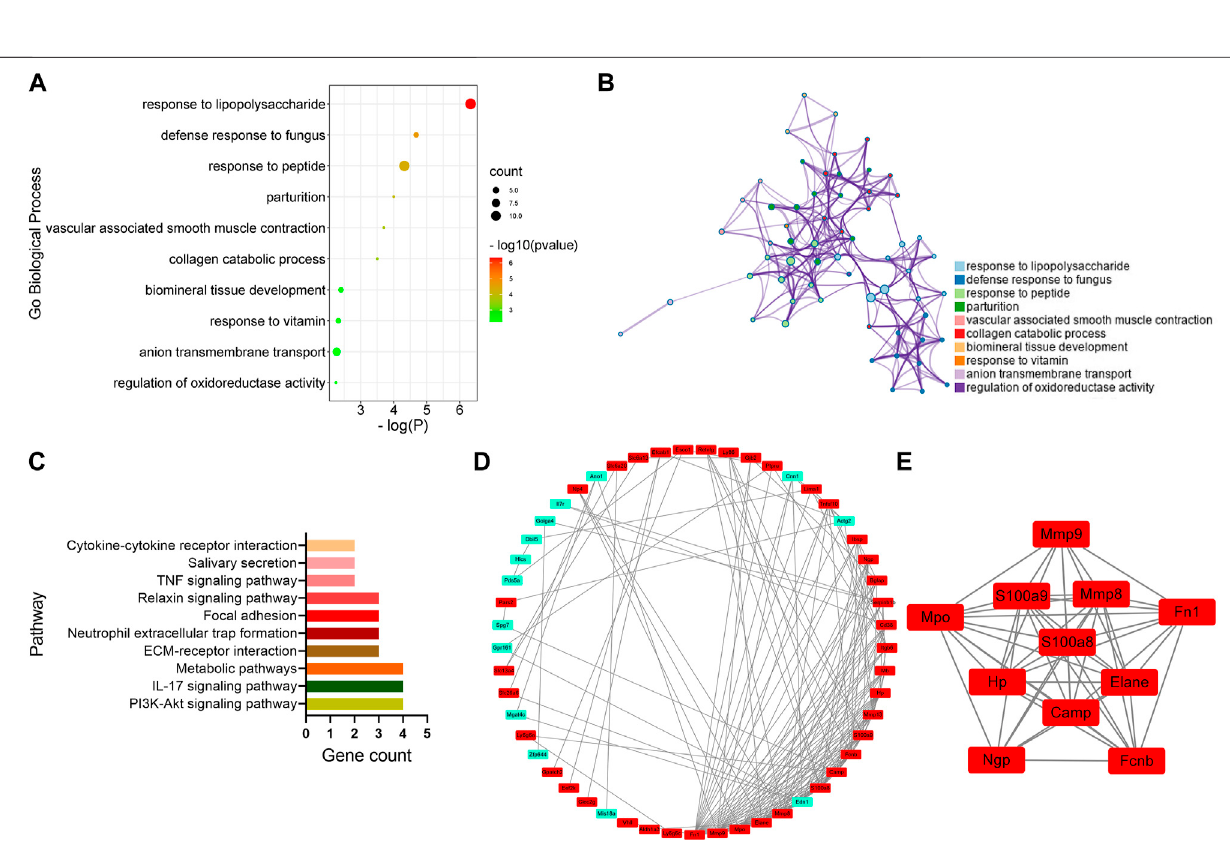
Frontiers in Pharmacology |